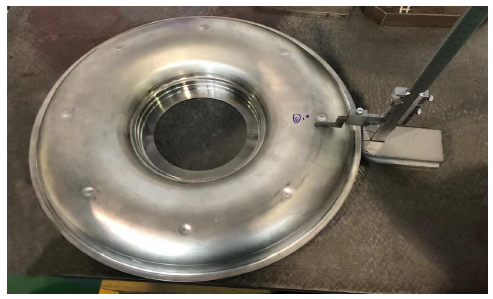
Figure 5. Schematic diagram of sample height measurement after welding.